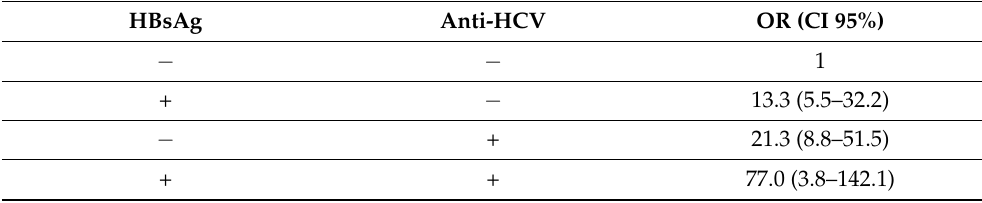
Table 1. Evidence for the additive interaction of the contemporary presence of HBsAg and anti-HCV positivity on the risk of HCC development (adapted from [9]).